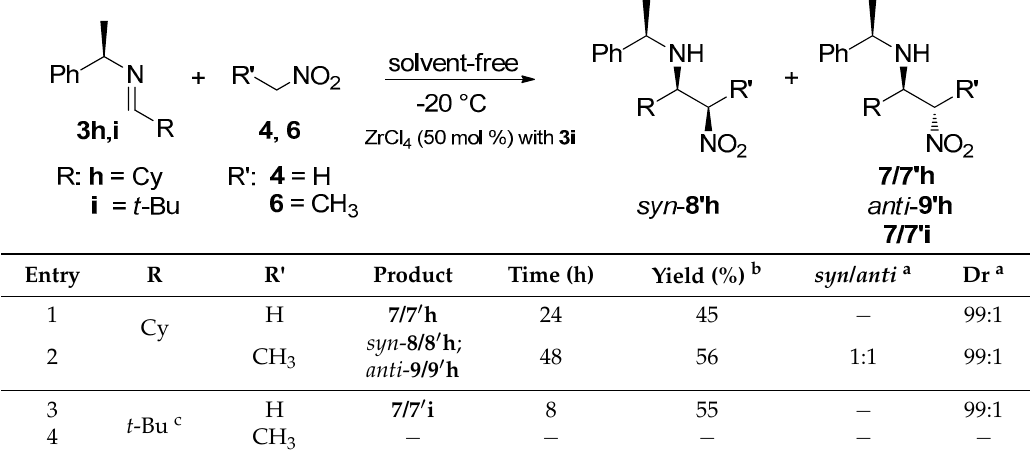
Table 3. Diastereoselective additions on different C -alkyl substituted